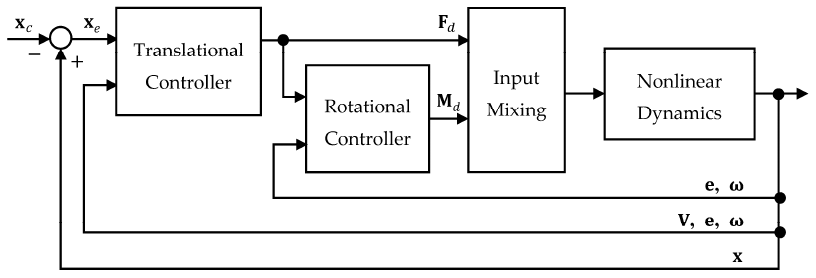
Figure 4. Block diagram of proposed flight control system.